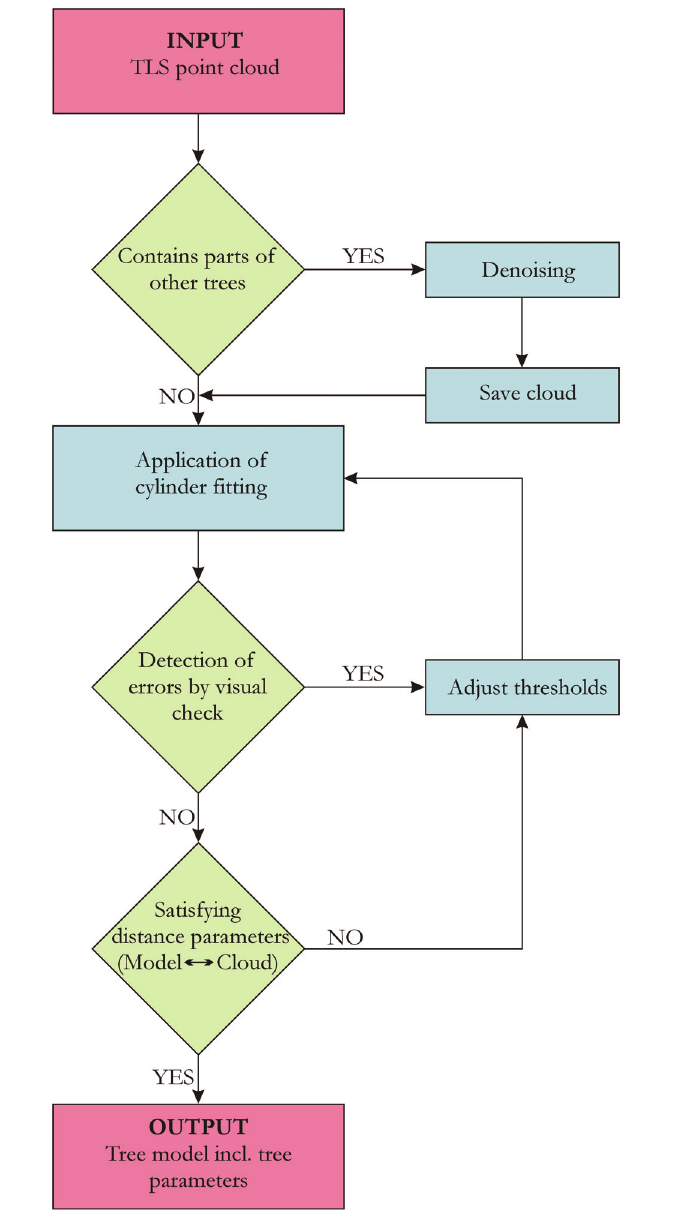
Figure A1. Data processing